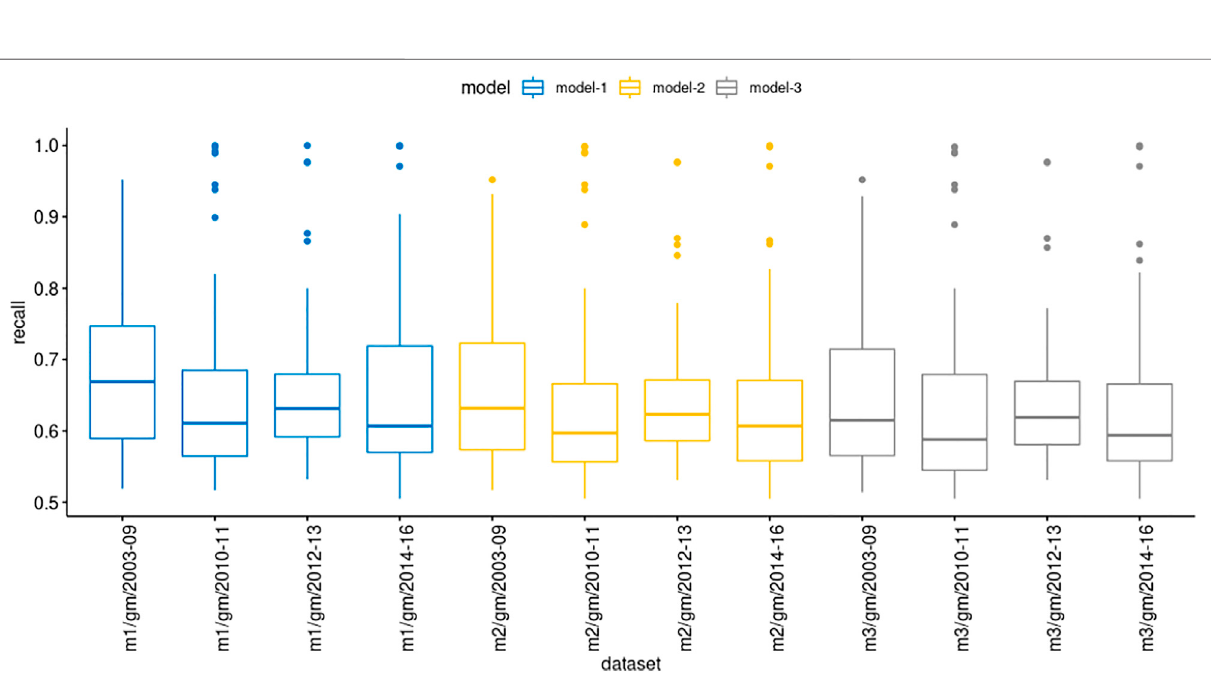
Frontiers in Bioinformatics |